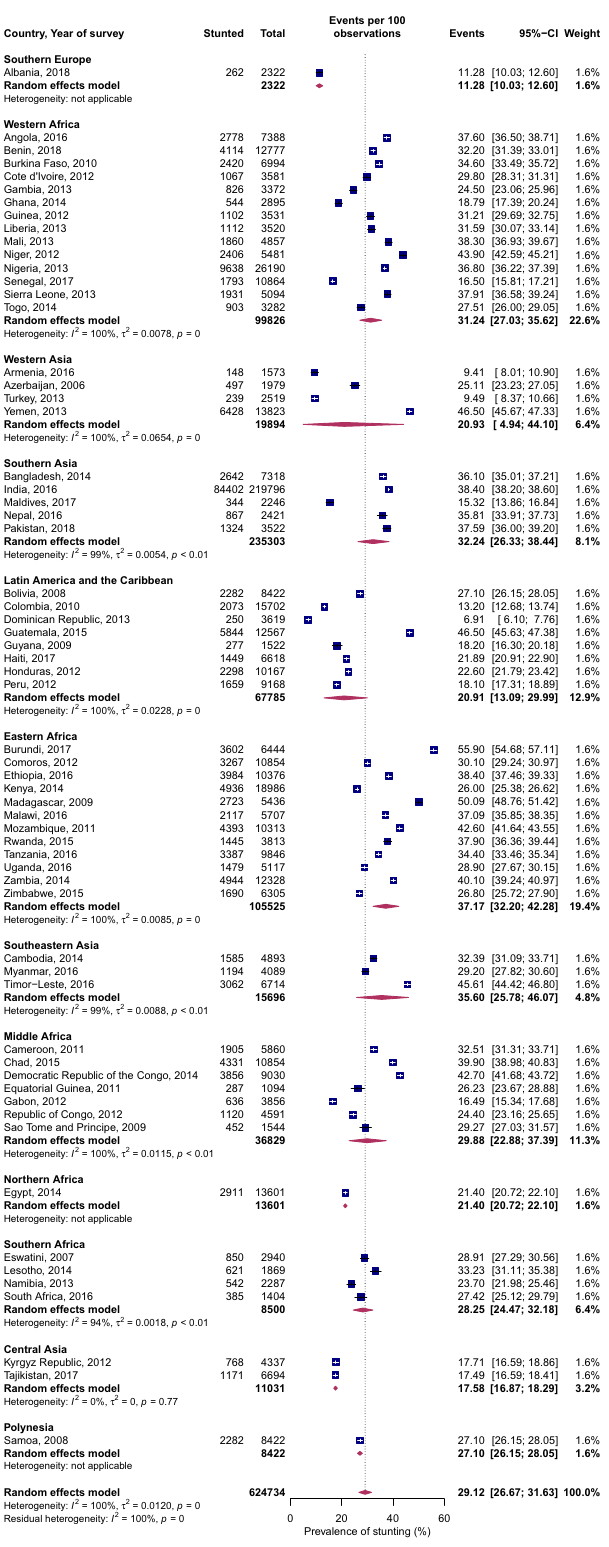
Figure 2. Forest plot of stunting prevalence by UN subregions of LMICs: event values represent the number of cases of stunting expressed as a percentage. Blue squares and their corresponding lines are the point estimates and 95% confidence intervals (95% CI). Maroon diamonds represent the pooled estimate of the prevalence for each subgroup (width denotes 95% CI). Weights are from the random-effects meta-analysis model described by DerSimonian and Laird 20 ( p for interaction comparing the different subgroups <